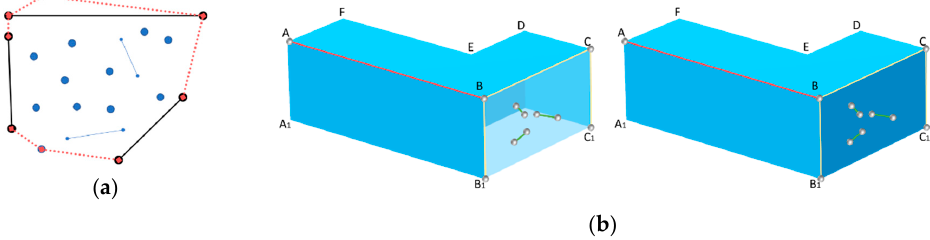
Figure 8. Example of the Line-and-Line Unit validation. ( a ) Red lines represent the convex hull; black lines are identified as Border Lines while the rest blue ones the Inner Edges. ( b ) Plane B 1 BCC 1 is validated by the LaL Unit B 1 B - BC - CC 1 .